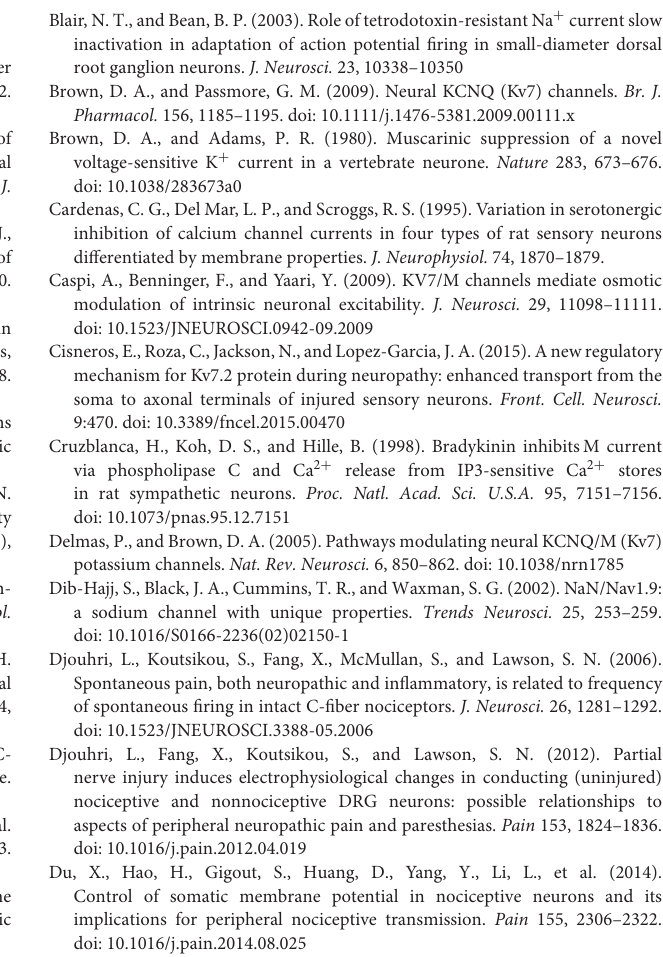
nociceptor-like neuron shows substantial depolarization followed by action potential discharge ( inset : expanded time scale) induced by puff application of capsaicin (5s, 1 µ M). The dotted line indicates the membranes potential before the stimulation ( − 58mV, representative of 10 neurons). Supplementary Figure 3 | Terminal g Kv7/M opposes membrane potential fluctuations. (A) Upper, Example of a current noise trace ( σ = 0.006) injected into the whole terminal tree of the multi-compartment model of nociceptive neuron with intact g Terminal Kv7 / M . Middle, simulated recordings of changes in membrane voltage in single terminal following injection of the current noise (showed above), expanded in y-axis in inset . Lower , simulated recordings of changes in membrane voltage in the central axon ( blue electrode in Figure 4 ) following injection of the current noise (showed above) to the terminal tree. Note that at this noise level no activity is elicited at either terminal or soma. (B) Same as (A) but g Terminal Kv7 / M is reduced by half. Note that in this conditions same noise level elicited spontaneous firing. Supplementary Figure 4 | The limits of terminal g Kv7 / M in preventing stimulus induced hyper-responsiveness of modeled nociceptive neuron. Graphic representation of the relationship between the terminal g Kv 7 and g Na(v)1.9 in eliciting increased responsiveness to 500ms, 100 pA square pulses. In normal conditions, when g Terminal Kv7 / M = 1 x g Terminal Kv7 / M and g Na(v)1.9 = 1 x g Na(v)1.9 , this stimuli evokes 1 spike ( blue area , see also Figure 4B ). The recordings performed at the proximal axon of the modeled neuron ( blue electrode in Figure 4 ). The number of spikes during 500ms step color coded (shown on the right). Note that when g Terminal Kv7 / M = 1 x g Terminal Kv7 / M , the number of spikes is increased when g Na(v)1.9 is increased above